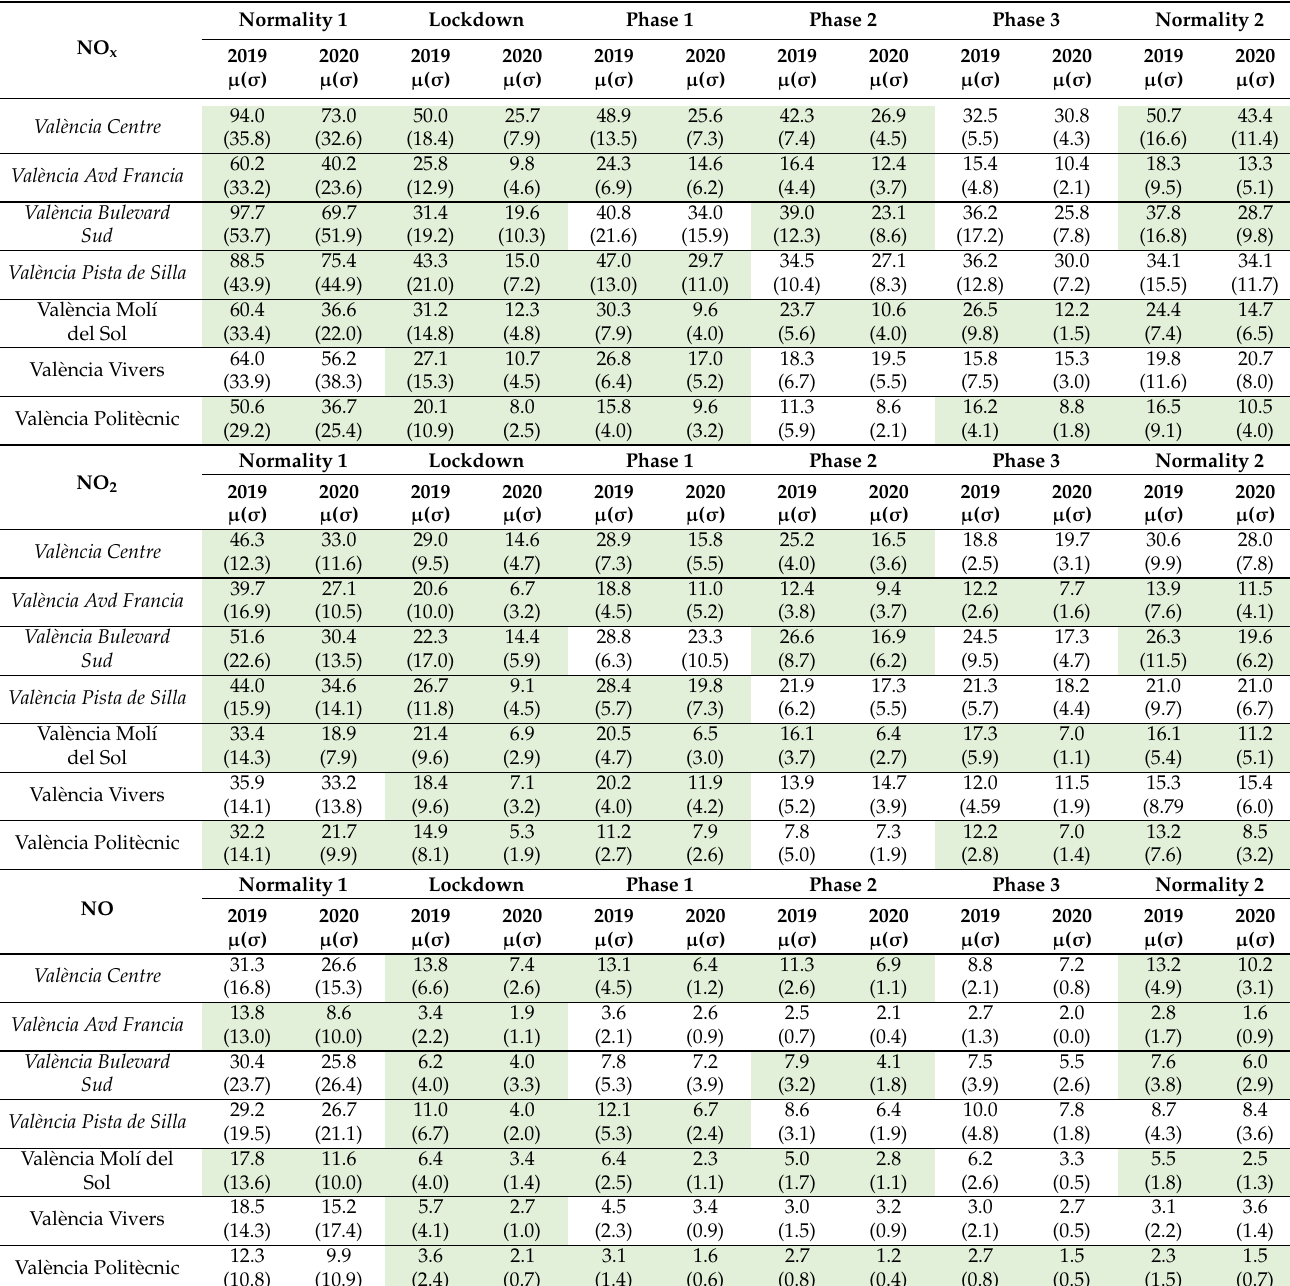
Table 3. NO x , NO 2 , and NO means and standard deviations are expressed in µ g · m − 3 . Green color denotes a significant ( p -value < 0.05) decrease between 2019 and